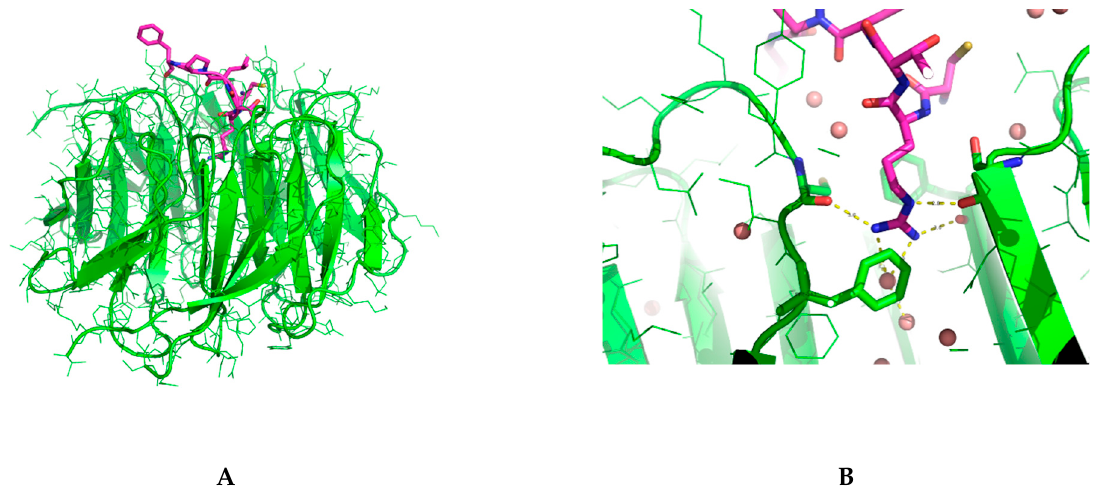
Figure 3. The cocrystal structure of D206115 with WDR5 (PDB code: 7DNO). ( A ) The overall complex structure. The WDR5 was shown in green cartoon mode and peptide in purple color. ( B ) The details of binding interactions between the arginine residue of D206115 and the WIN site of WDR5. Water molecules are shown in sphere.